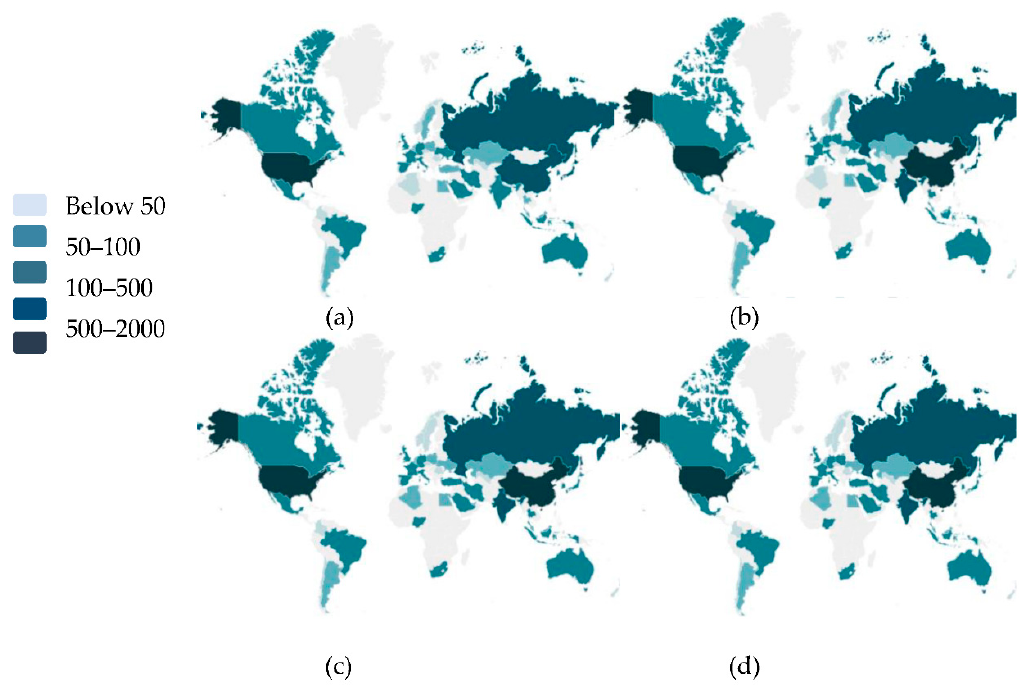
Figure 3. Spatial distribution of total energy consumption in the world: ( a – d ) represent the total energy consumption in 2005, 2010, 2015, and 2020.